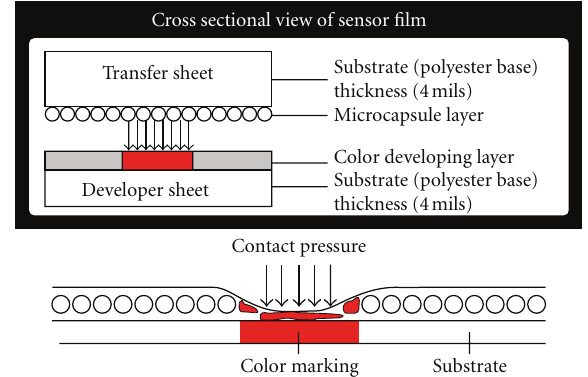
Figure 1: Cross sectional view of PRESSUREX film illustrating mechanism of color mapping from contact